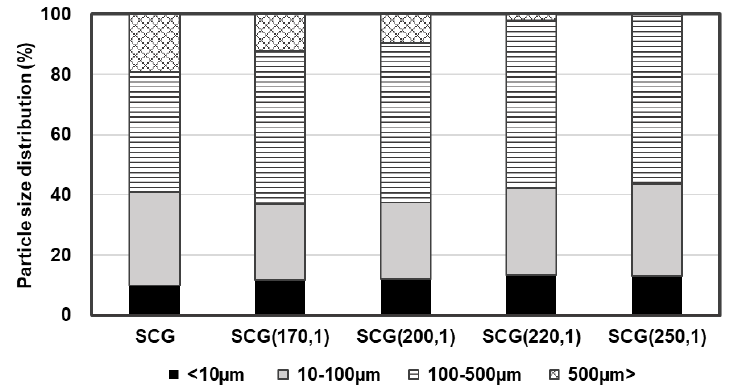
Figure 3. The particles sizes distribution of SCGs at different reaction temperatures.